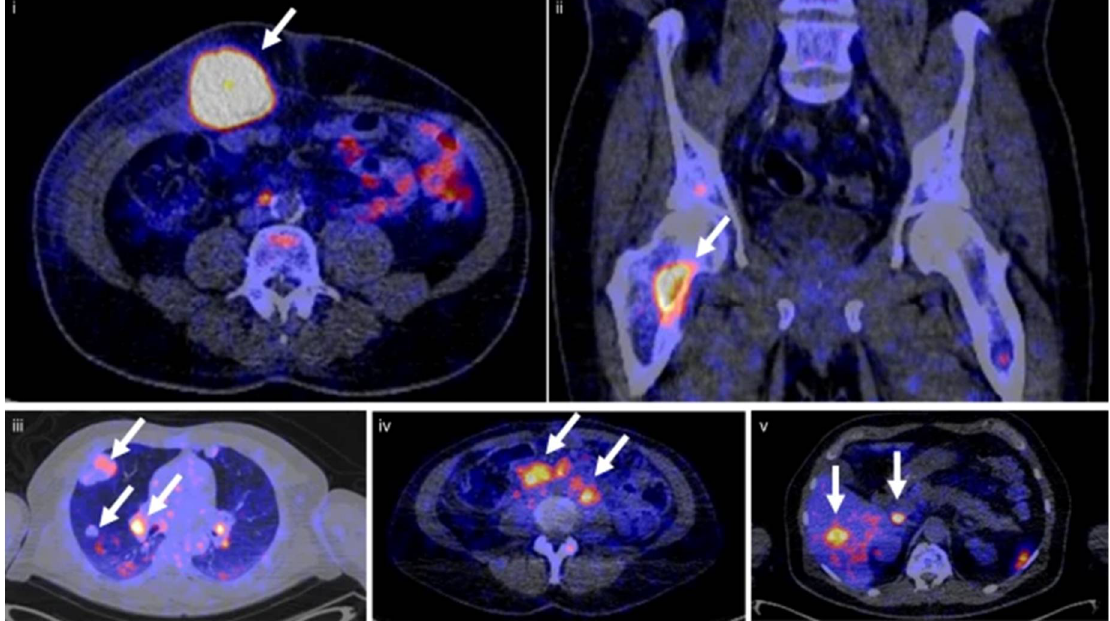
Figure 4. Tumor uptake of [ 89 Zr]Zr-sucDf-atezolizumab in cancer patients. Examples of PET/CT images of four patients illustrating the [ 89 Zr]Zr-sucDf-atezolizumab tumor uptake in five different locations on day 7 post-injection (white arrows indicate tumor lesions; PET scans were performed once per patient and time point). Images ( i ) and ( ii ) are from the same patient, whereas images ( iii ), ( iv ), and ( v ) are from separate patients. The figure is reproduced with permission from